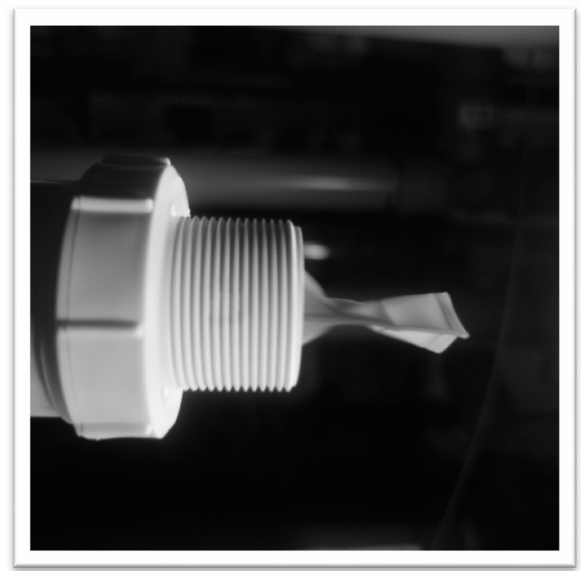
Figure 3. Waterless trap seal connected to the 50 mm pipe using a pipe